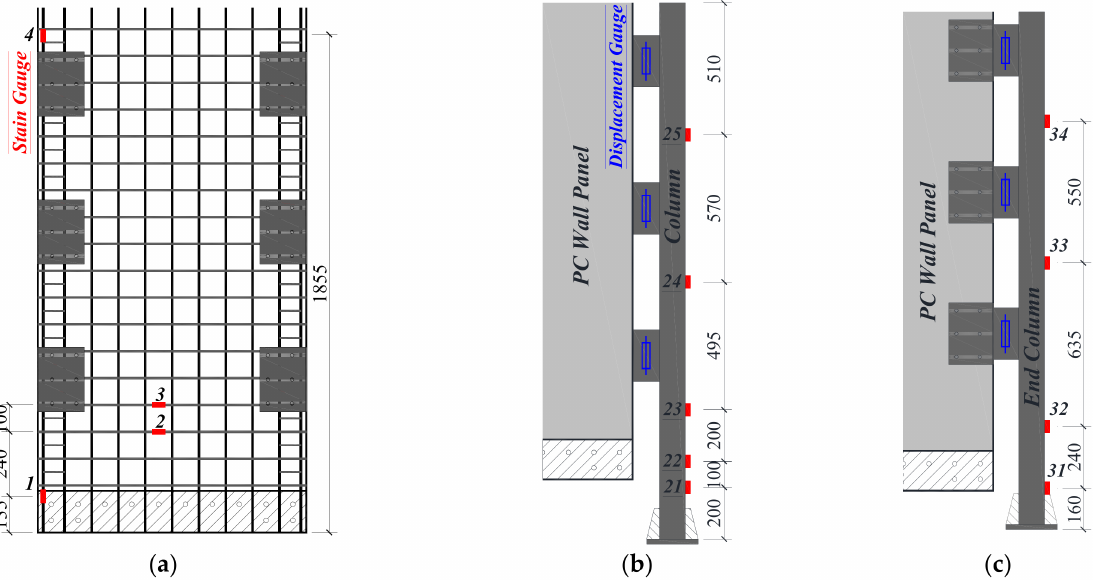
Figure 10. Instrumentation of wall. ( a ) Gauges mounted on wall; ( b ) Gauges mounted on W1-R end column; ( c ) Gauges mounted on W2-R end column.